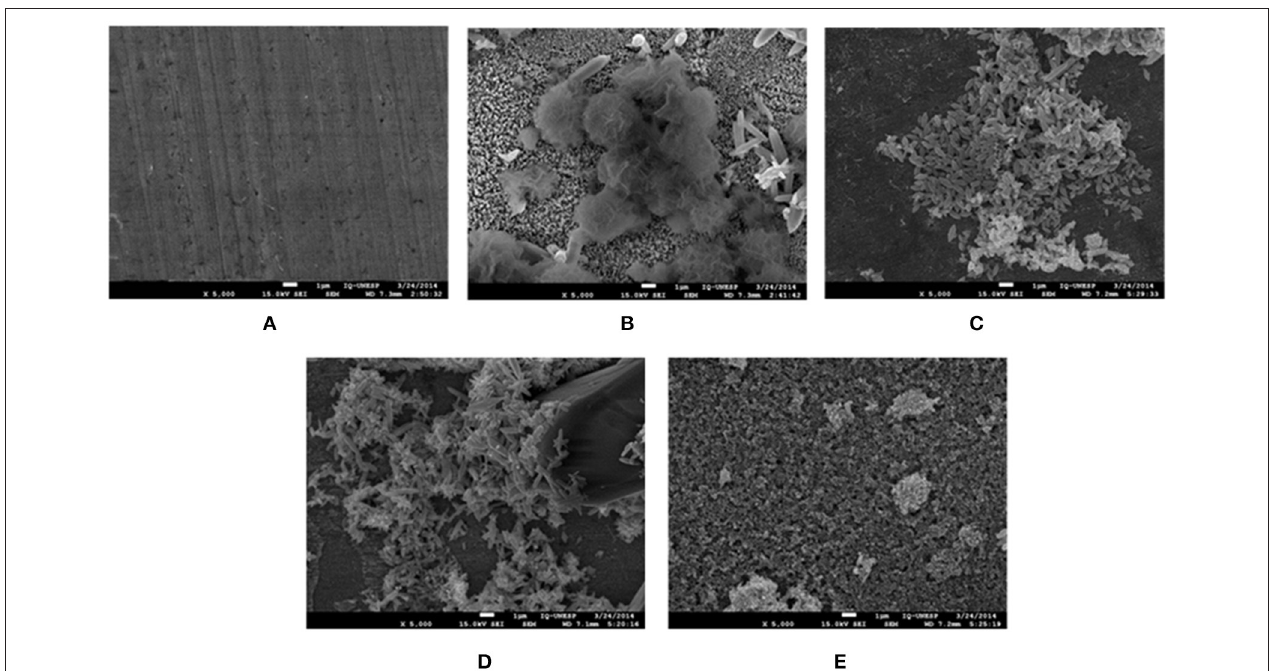
FIGURE 11 | SEM micrographs of zinc surface before (A) and after 15 days of immersion in 0.1mol L − 1 NaCl solution in the absence (B) and presence of 5 × 10 − 3 mol l − 1 VCI: (C) CCHA; (D) CDCHA; (E) CETA.